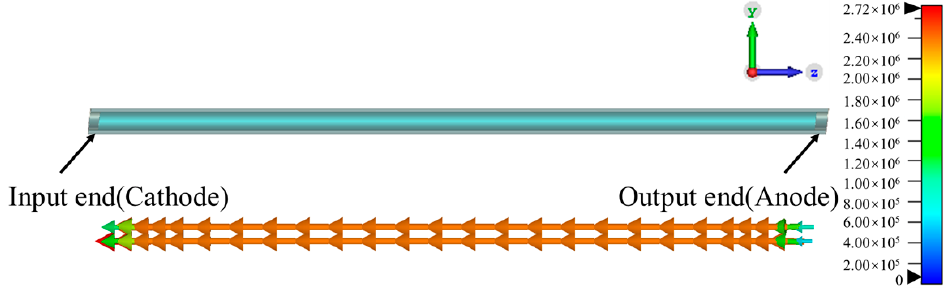
Figure 3. Electric field distribution inside MCP hollow-core glass fiber.